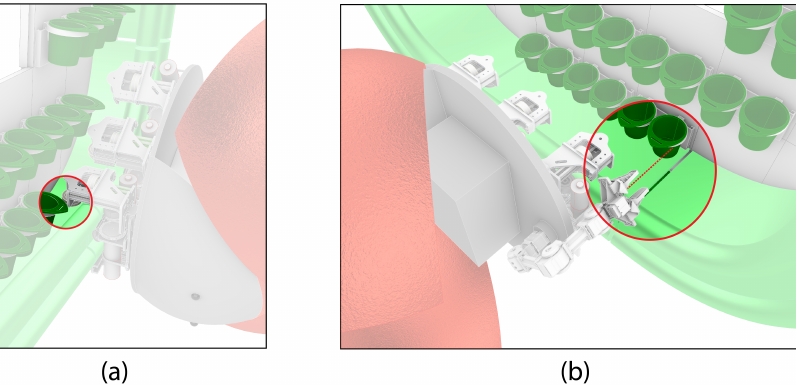
Figure 3. ( a ) Robot collision with plant pots if track height is too low, ( b ) Inability of robot to reach plant pot if track height is too